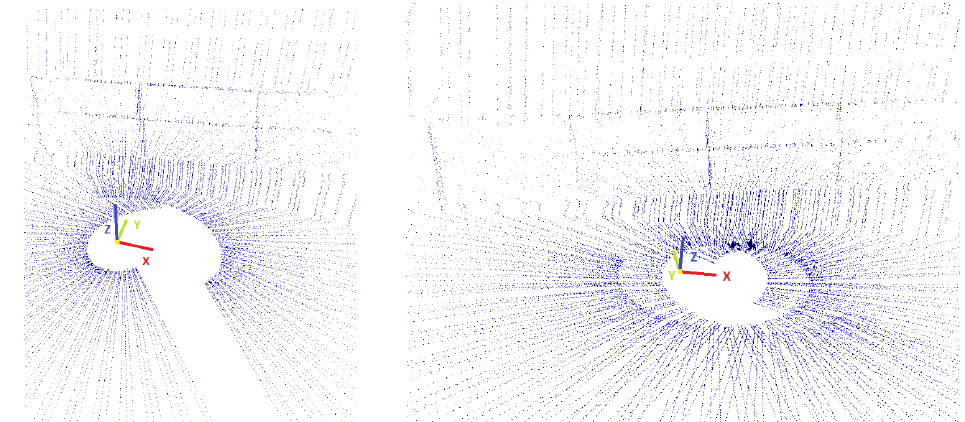
Figure 6. Details of leveled 3D laser scans obtained with a sensor’s head rotation of 180 ◦ ( left ) and 360 ◦ ( right ) while Andabata was moving along a